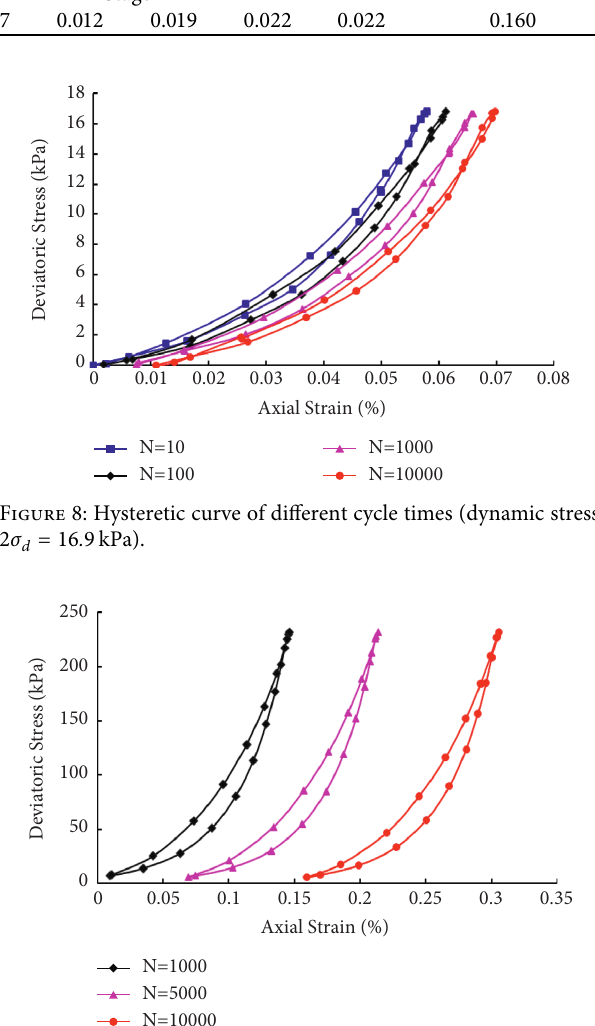
Figure 9: Hysteretic curve of different cycle times (dynamic stress 2 σ d � 226 . 4 kPa).